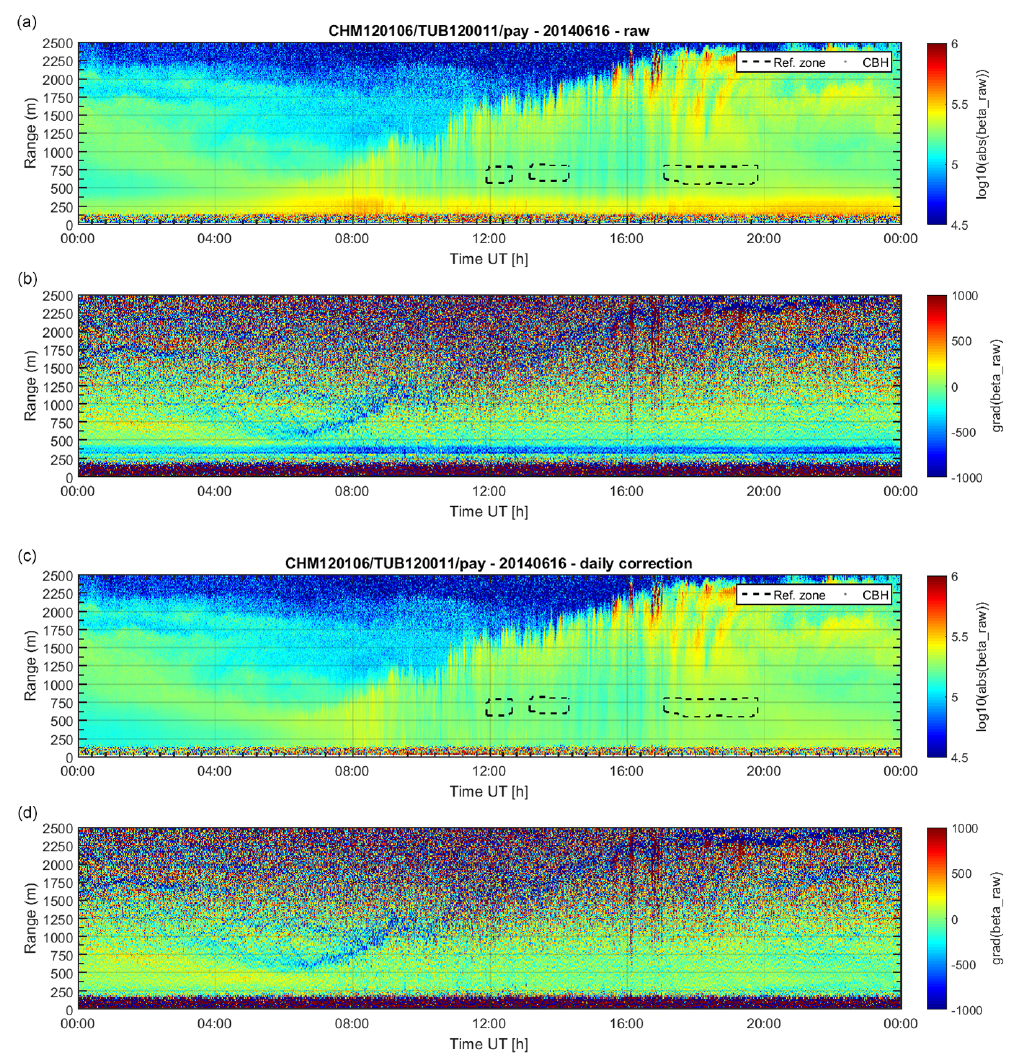
Figure 2. CHM15k measurements at Payerne for 16 June 2014. (a, c) : Logarithm of the range corrected signal. (b, d) : Gradient of the range corrected signal, (a) and (b) : without correction and (c, d) : with overlap correction. The reference zones from which the overlap correction was calculated are circled with black dashed